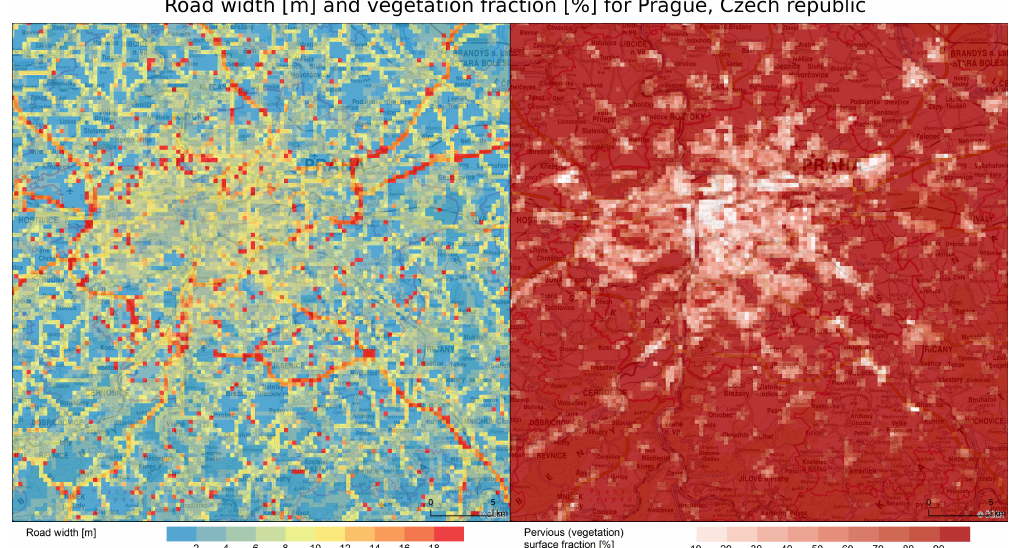
Figure 3. The final road width (meters) and vegetation fraction (%) map at the original 333m resolution used to derive the 2D urban input for